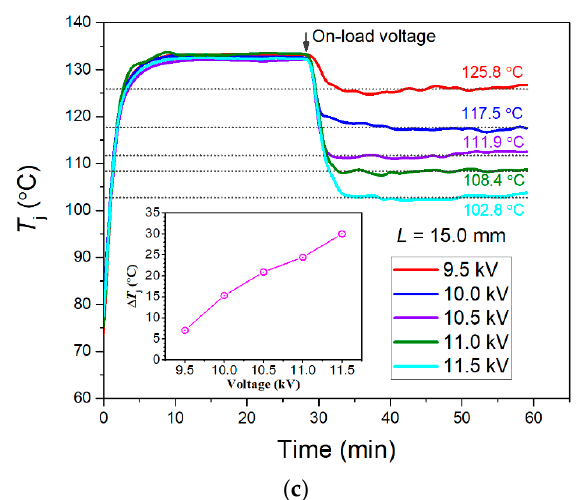
Figure 6. Evolution of the junction temperature for the LED filament when applied with different voltages on electrodes: ( a ) electrode gap of 6.0 mm; ( b ) electrode gap of 10.0 mm; and, ( c ) electrode gap of 15.0 mm.